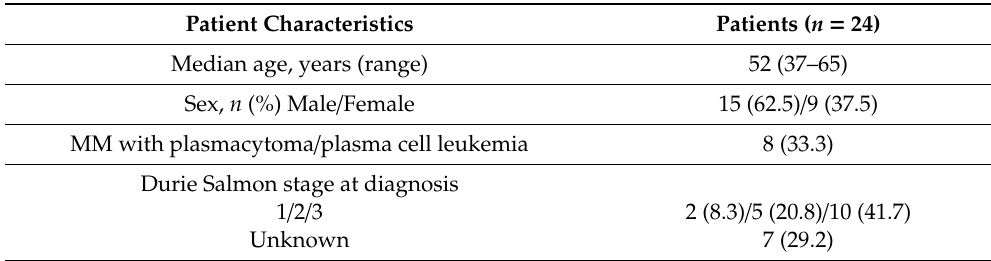
Table 1. Baseline characteristics of patients. MM, multiple myeloma; ISS, International Staging System; Ig, immunoglobulin; AutoSCT, autologous stem cell transplantation; alloSCT, allogeneic stem cell transplantation; CR, complete response; VGPR, very good partial response; PR, partial response; SD, stable disease; PD, progressive disease; HLA, human leukocyte antigen; MAC, myeloablative conditioning; RIC,reducedintensityconditioning; GVHD,graft-versus-hostdisease; MTX,methotrexate; M, male; F, female. * High risk cytogenetics: p53 deletion for one patient, t (4;14) for one patient and p53 deletion + t (14;16) for one